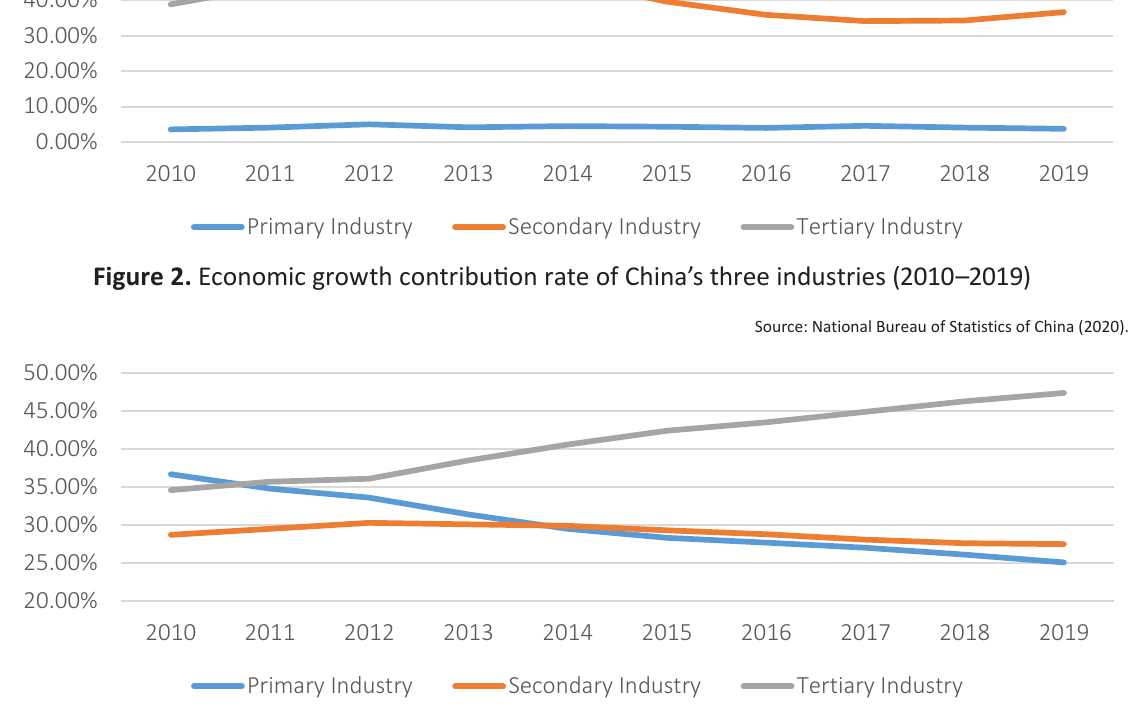
Figure 3. Dynamic changes of China’s employment structure (2010–2019)